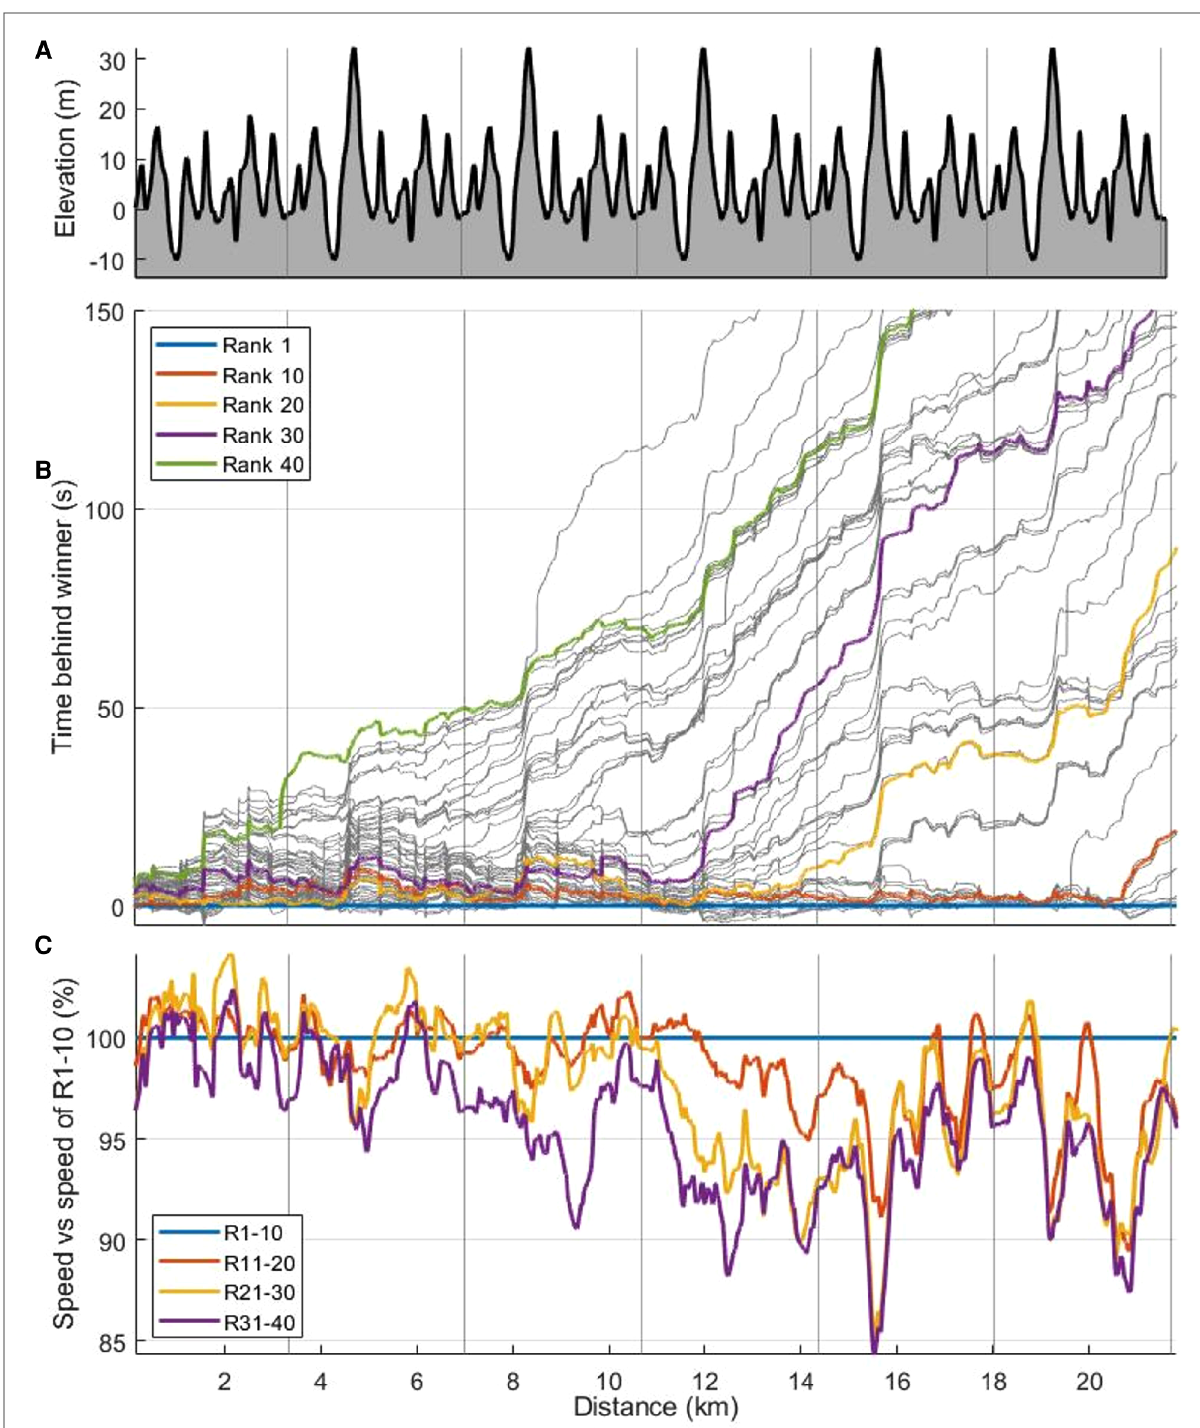
FIGURE 4 Elevation ( A ), time behind winner [s] for individual skiers ( B ) and continuous speeds ( C ) for the lower performance-groups (group R11 – 20, R21 – 30, and R31 – 40) compared to the fi rst group R1 – 10 [%] as a function of distance [km] in a 21.8 km mass-start competition. R1 – 10 denotes ranks 1 – 10, R11 – 20 ranks 11 – 20, R21 – 30 ranks 21 – 30, and R31 – 40 ranks 31 –